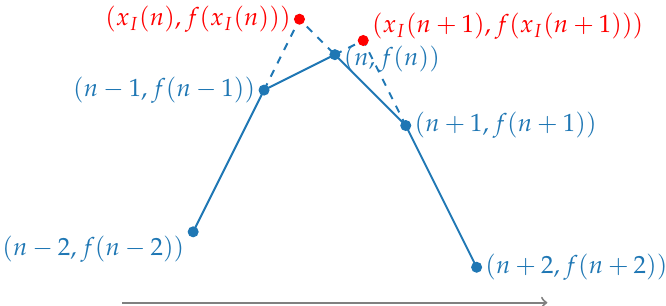
Figure 3. Illustration of conditions (23b) and